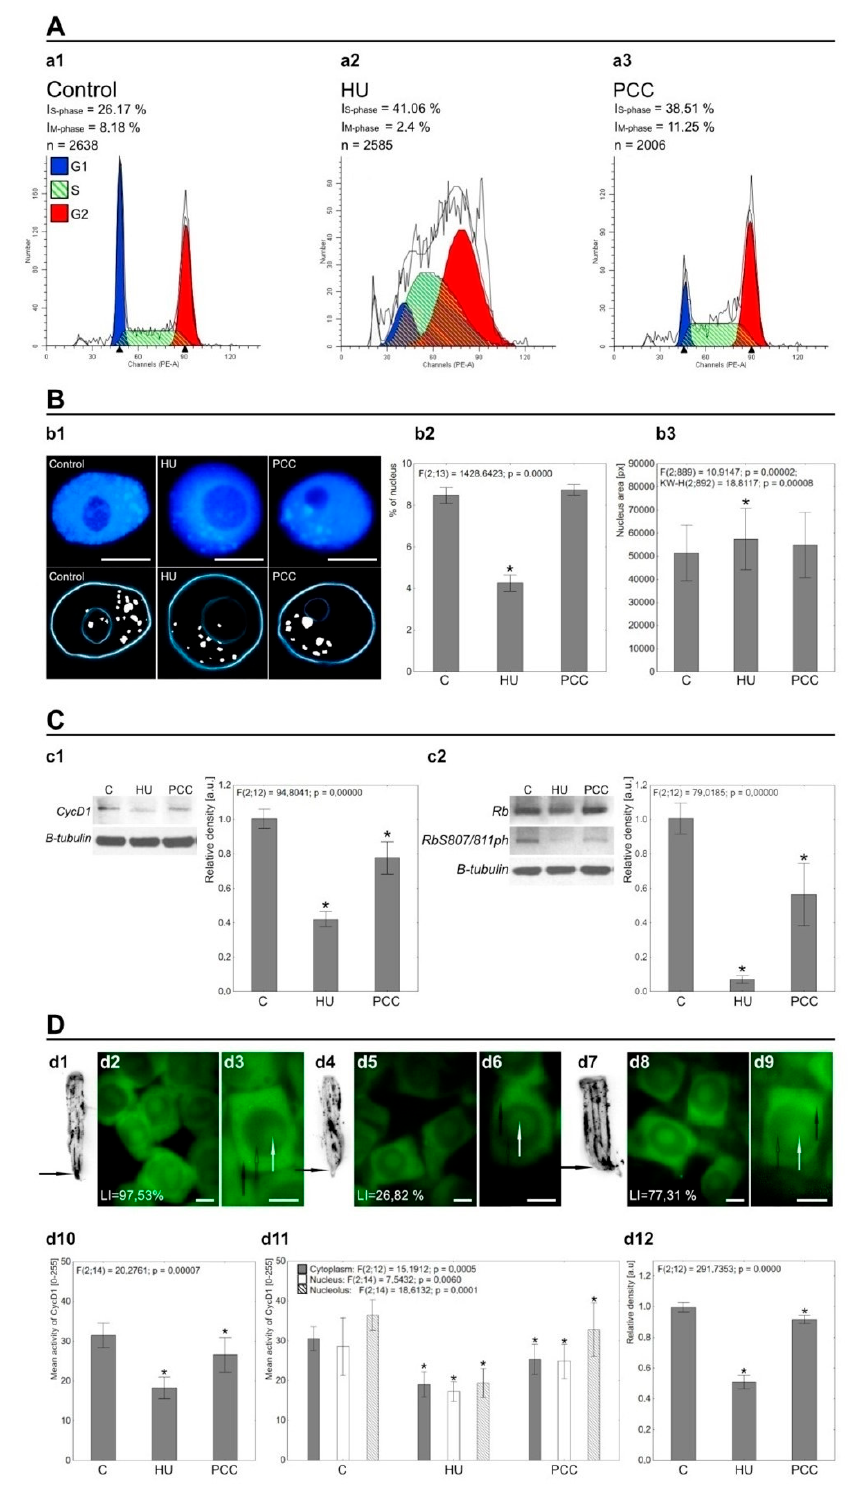
Figure 1. ( A ) The results of cell cycle analysis conducted using flow cytometry. The number of S-phase (I S-phase ) cells increases significantly after HU treatment ( a2 ), which is an effect of HU inhibition of the replication itself (cell cycle synchronization; S-phase arrest; cell cycle checkpoint activation). At the same time, the percentage of actively dividing cells (I M-phase ) is visibly lowered compared to control cells. Co-treatment with HU and CF (PCC, as shown at a3 ) increases both the S-phase and the mitosis percentage, which occurs due to the cell cycle checkpoint overriding caused by caffeine. ( B ) The effects of HU and HU/CF treatment on the heterochromatin regions of nucleus. The